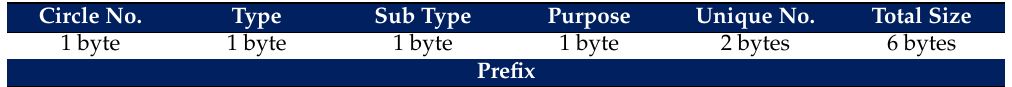
Table 2. Sensor noder unique